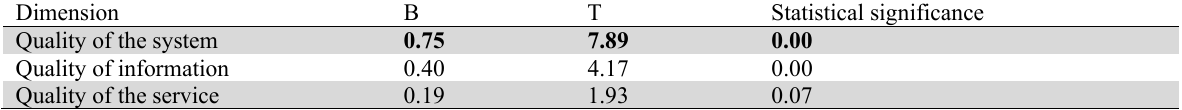
The results for applying the Multiple Linear Regression effect on the independent variable (quality of the system, quality of information and the quality of services) on the dependent variable (the satisfaction of AIS users)